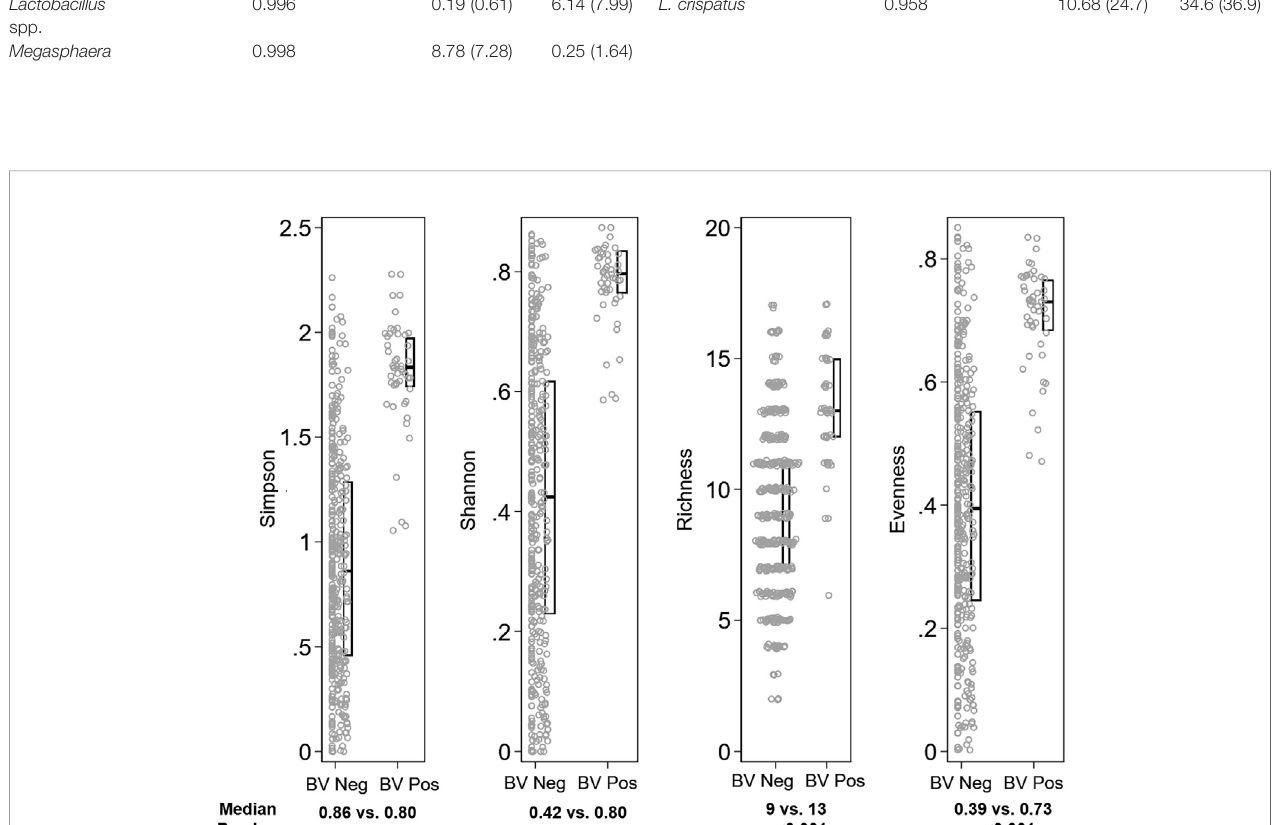
FIGURE 4 | Distribution of alpha diversity metrics by Bacterial vaginosis (BV) status. Legend: The distribution of alpha diversity metrics (Simpson, Shannon, Richness, and Evenness) are shown on the y-axis, separately for girls with Nugent score 0-6 ( “ BV Neg ” , N=382) and Nugent score 7-10 ( “ BV Pos ” , N=49) on the x- axis. Within panels, each grey dot represents a single observation. Box plots indicate the median (horizontal bar) and interquartile range (lower 25 th percentile and upper 75 th percentile). Below each graph, the median value for each alpha diversity metric is reported for “ BV Neg ” and “ BV Pos ” observations, with Wilcoxon rank sum p-value of the comparison reported beneath the